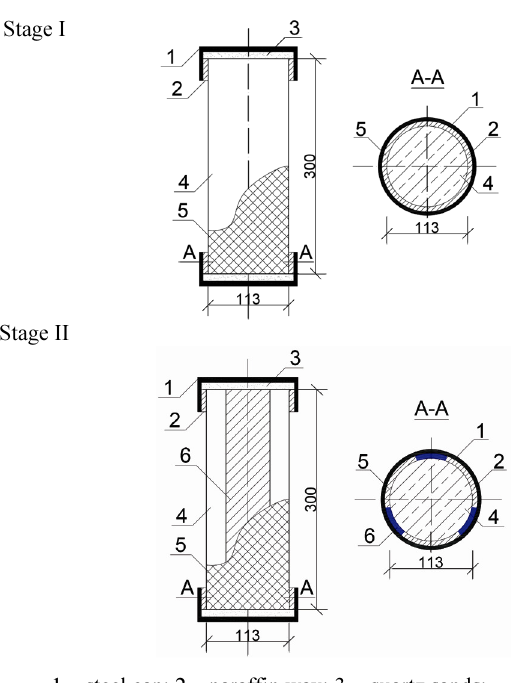
Fig. 1. Fabricated specimens